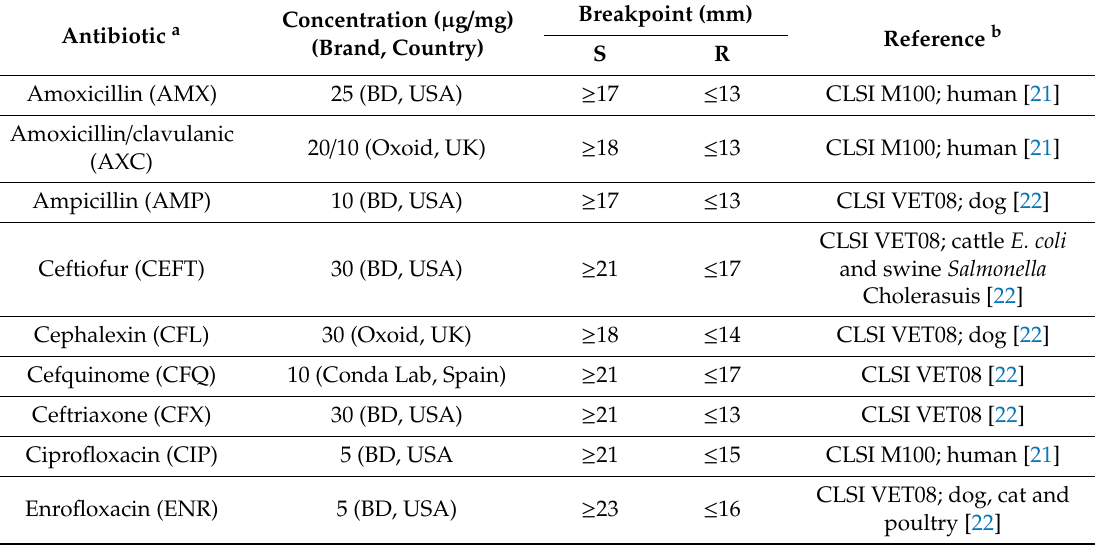
Table 1. Concentrations and breakpoints of the antibiotic disks used for the disk di ff usion method. Antibiotic